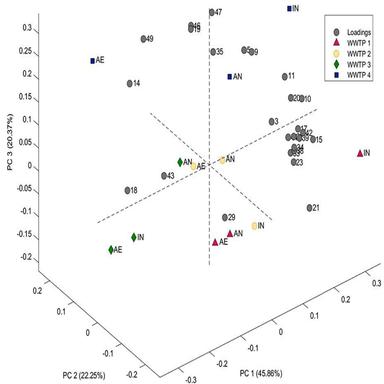
PCA biplot of the samples' scores and variables' loadings using three principal components. Score triangles/dots/diamonds/ are respectively for the four WWTPs. Identification of sample treatment stages are: IN, influent; AE, aerobic; and AN, anaerobic (denitrifying). Variables' loadings are identified with grey dots and they refer to the MCR components given in with the same number.